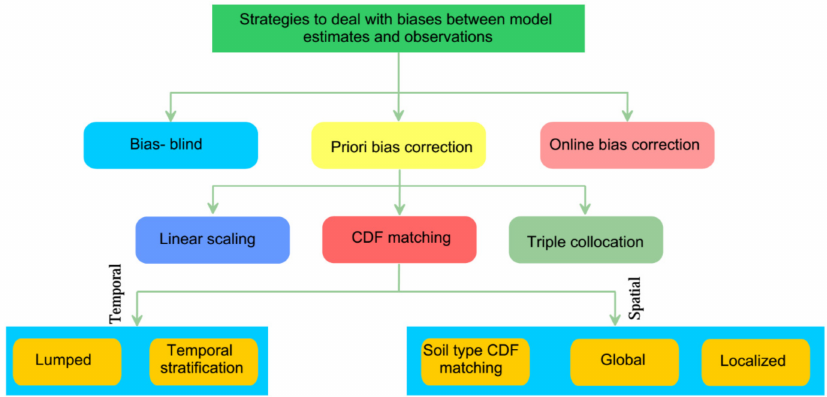
Figure 6. The applied strategies to deal with bias between LSM estimates and satellite-derived